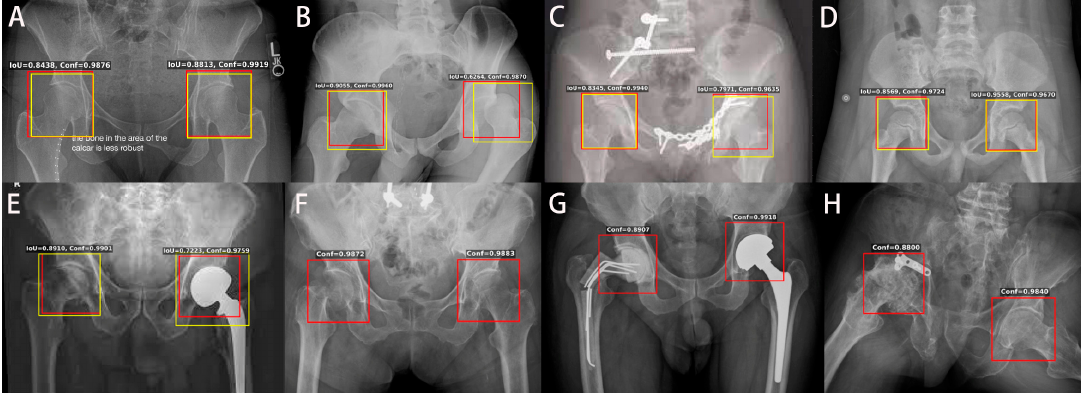
Figure 4. Visualization of hip ROI detection results on the testing dataset. Yellow boxes indicate manual labels, and red boxes indicate detected hip ROIs. In all scenarios, the ROI could be detected well in both hips. ( A ) A radiograph with some text outside the key hip area. ( B ) A radiograph with left hip dislocation. ( C ) A radiograph with plates on the left pubic ramus and acetabulum. The hips were detected correctly. ( D ) A radiograph of pediatric patients. ( E ) A radiograph showing left hip replacement and deformity of the right hip. ( F ) Right proximal femoral fracture. ( G ) The right hip showing a fracture of a temporal cemented prosthesis and left total hip replacement. ( H ) Right acetabular fixation with plate with destructed femoral head.